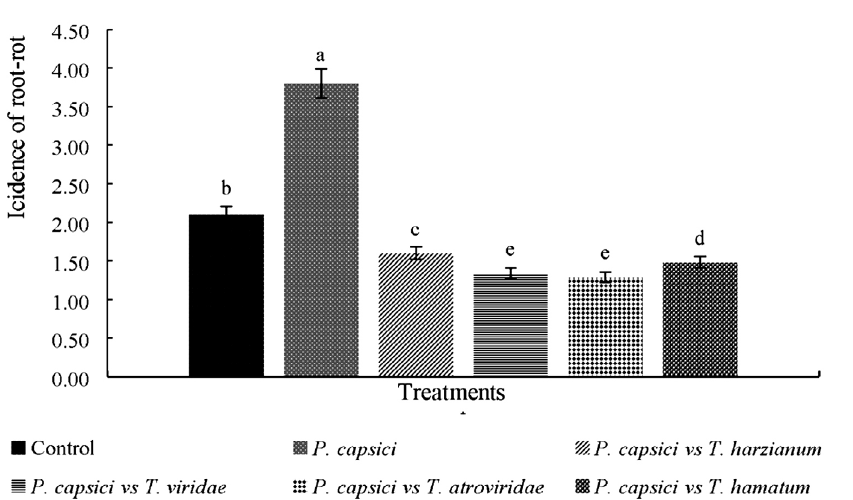
Fig. 3. Comparison of incidence of root rot in Manzano chili( Capsicum pubescens ) seedlings germinated from seeds treated with native strains of Trichoderma spp. and P. capsici in nursery 20 dai.*Different letters mean significant difference between treatments according to Tukey-Kramer ( p <